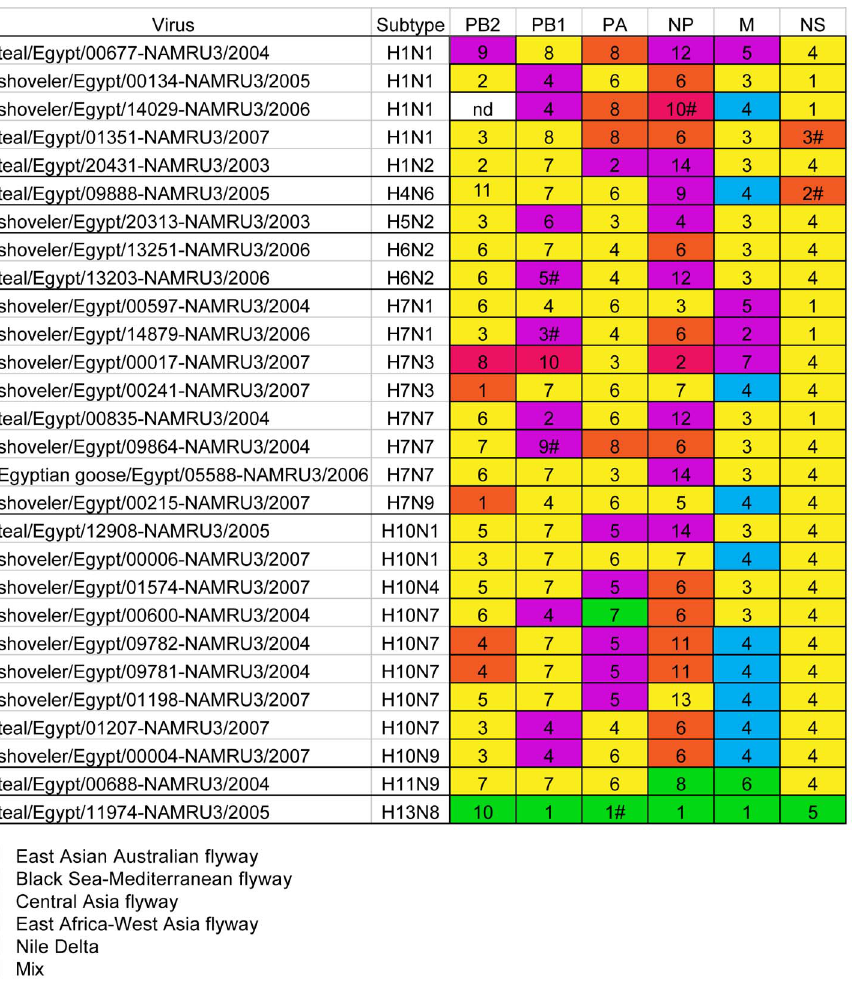
Figure 3. Phylogenetic groups of migratory flyways of viruses from this study. Viruses identified in this study and included in the TMRCA analysis are grouped according to their flyway in the dated phylogenetic tree (Figure 2). Subtypes are also included. Color code is indicated in the figure legend and reflects the inferred flyway in which the Egyptian viruses grouped (red for East Asian-Australian flyway, purple for Black Sea- Mediterranean flyway, green for Central Asian flyway, blue for East African-West Asian flyway, orange for Nile Delta and yellow if the group contained 2 or more reference viruses collected from different flyways). Viruses from this study that did not cluster with any other viruses from Figure 2 are indicated with ( # ) behind the number and were assigned to flyways that was inferred from large trees (data not shown).